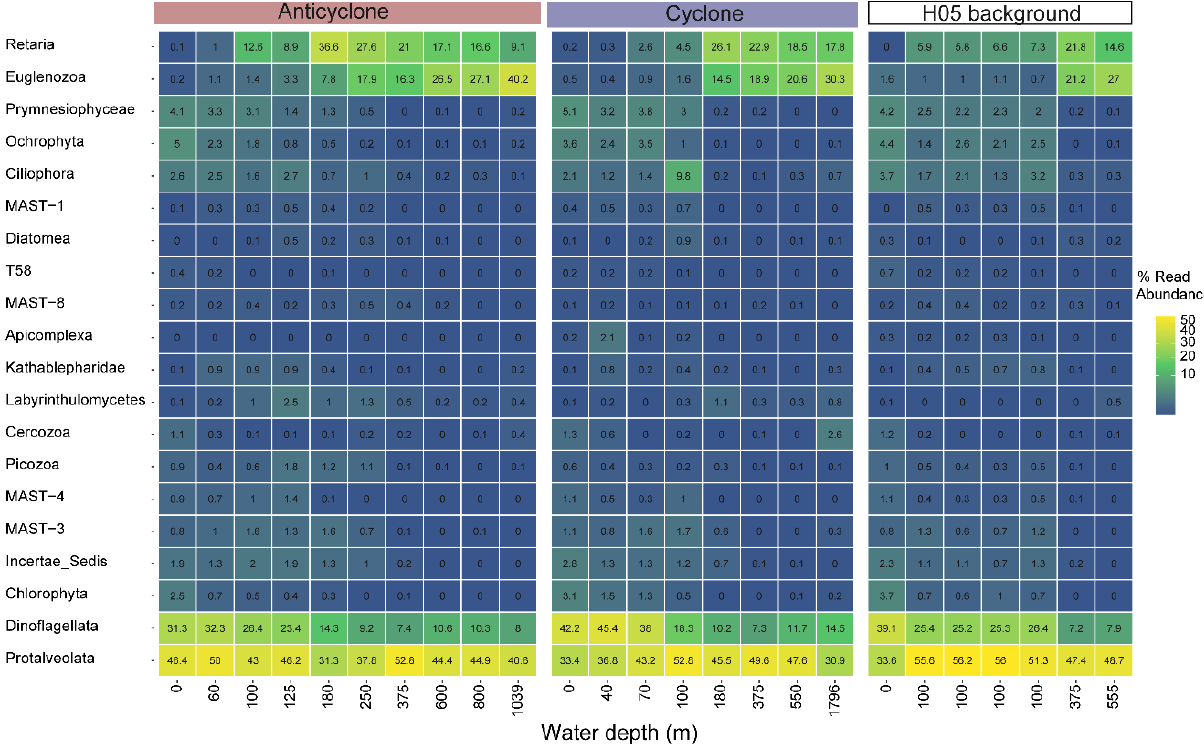
Figure 5. The relative abundance of the 20 most abundant unicellular eukaryotic lineages (phylum level), collected in cyclonic and anticy- clonic eddies and at an uninfluenced background station (H05) in the southeastern Mediterranean Sea during October 2018, as estimated by read abundance. Results of replicate casts at anticyclone and control H05 stations are shown.